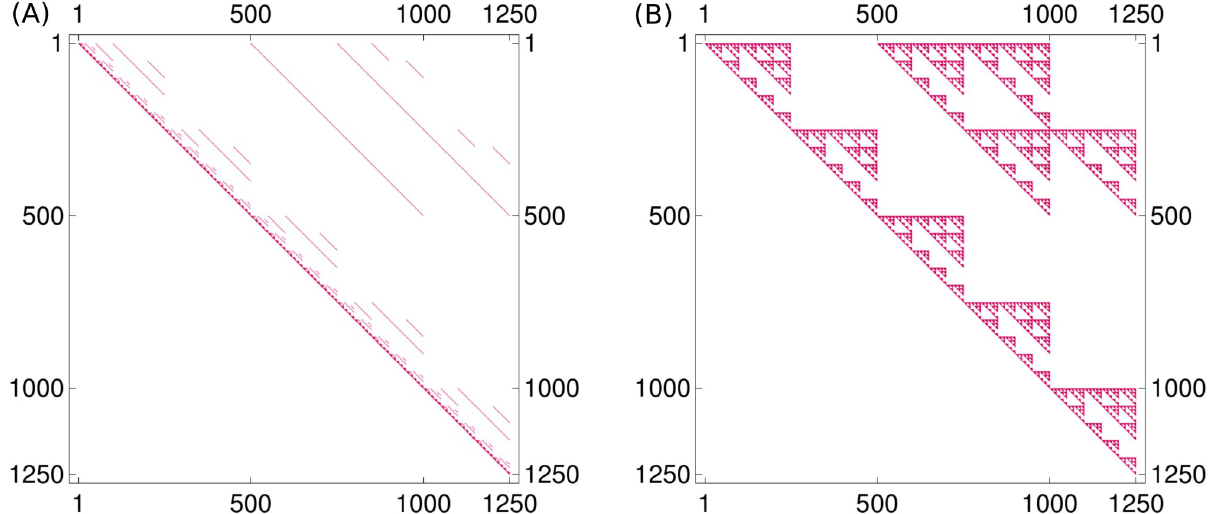
Fig 3. Sparse matrix structure. (A) The system matrix ( A + B + C + D + E + F ) of the linear model is a very sparse matrix, i.e., only a few entries are nonzero. These nonzero entries are colored red in the plot, which also illustrates the fact that ( A + B + C + D + E + F ) is an upper triangular matrix. (B) The sparsity structure of the matrix expm( A + B + C + D + E + F ), which is reminiscent of a Sierpi ń ski fractal, is due to the individual matrices being the Kronecker product and sum of matrices. The two plots also illustrate nicely how modeling sparse local interactions in the matrix ( A + B + C + D + E + F ) can have a more global effect in expm( A + B + C + D + E + F ).